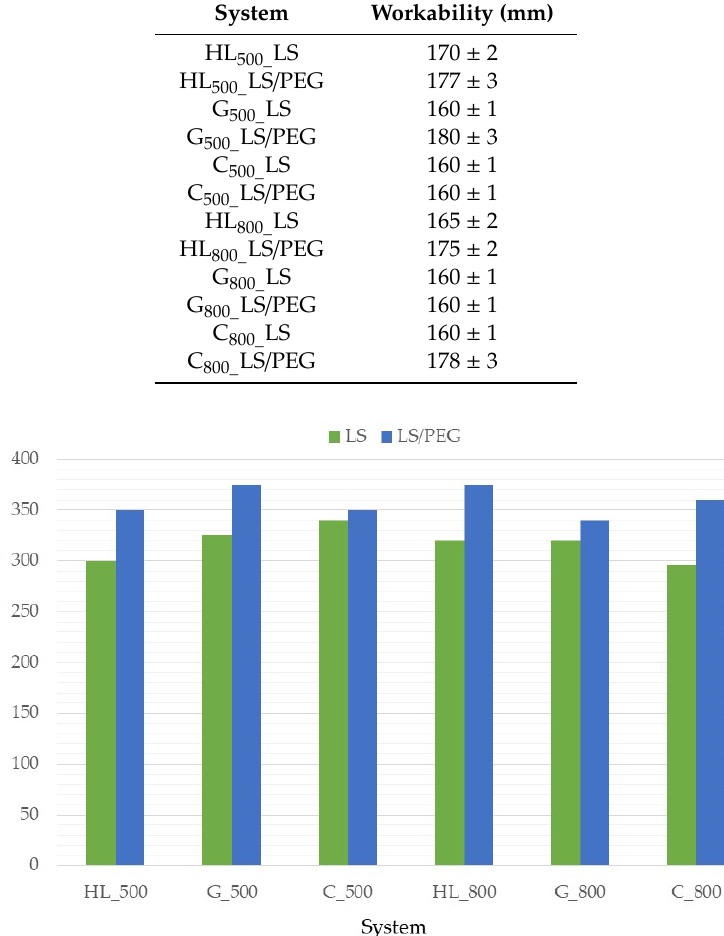
Table 2. Values of workability of the mortars possessing di ff erent compositions.